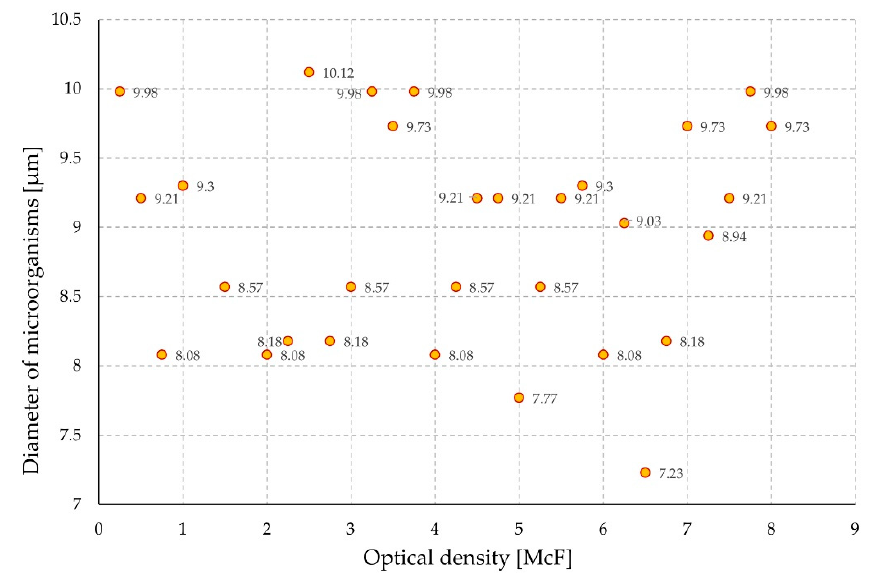
Figure 6. The diameter of microorganisms in relation to the optical density of the suspension. Additionally, the circumference of the microorganism was measured (Figure 7). No quantitative relationships were found.